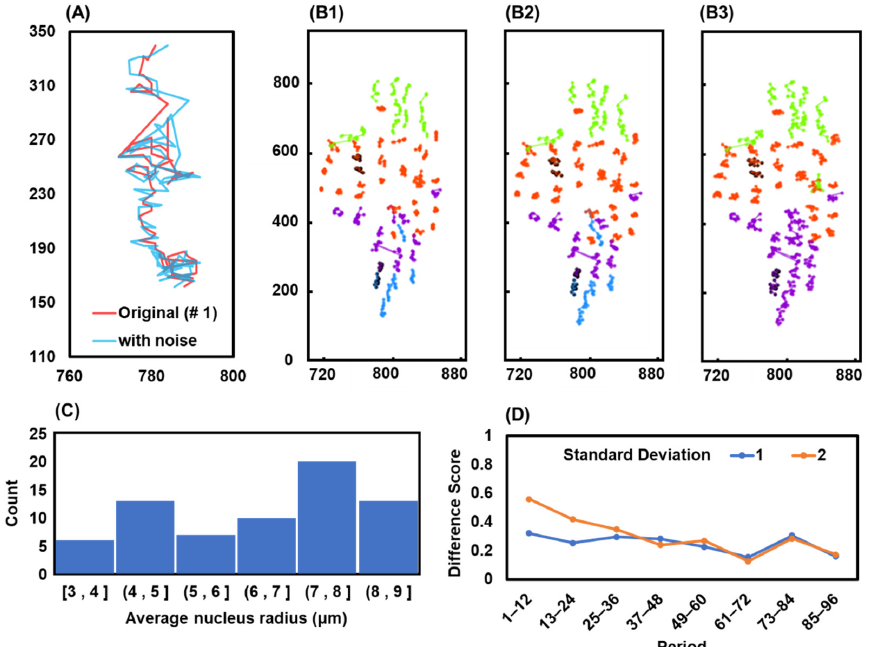
Figure 5. Robustness of the method. ( A ) The original trajectory of Cell ID 1 (red) and the trajectory with Gaussian noise of standard deviation σ = 2 (blue). ( B1 ) Cell tracks’ positions combined with clusters’ result under time slice 49–60. ( B2 – B3 ) All trajectories are with noise of standard deviations = 1, 2. ( C ) Histogram of average radius of cell nucleus ( μ m). ( D ) The difference score of all clustering results under different standard deviations (from the mean of three calculations in each σ ). The sample sizes for each time period are 92 cells.